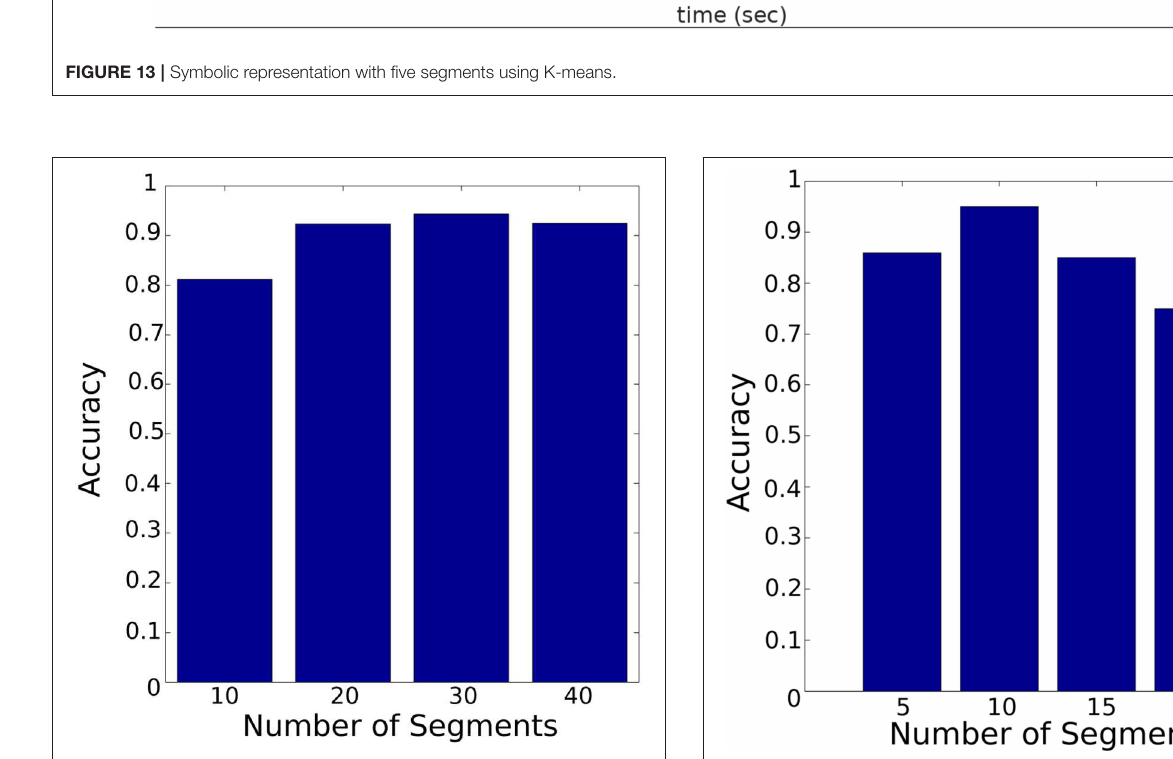
FIGURE 15 | Classifier accuracy with K-means segmentation using different number of segments. The best accuracy was achieved with 10 segments.